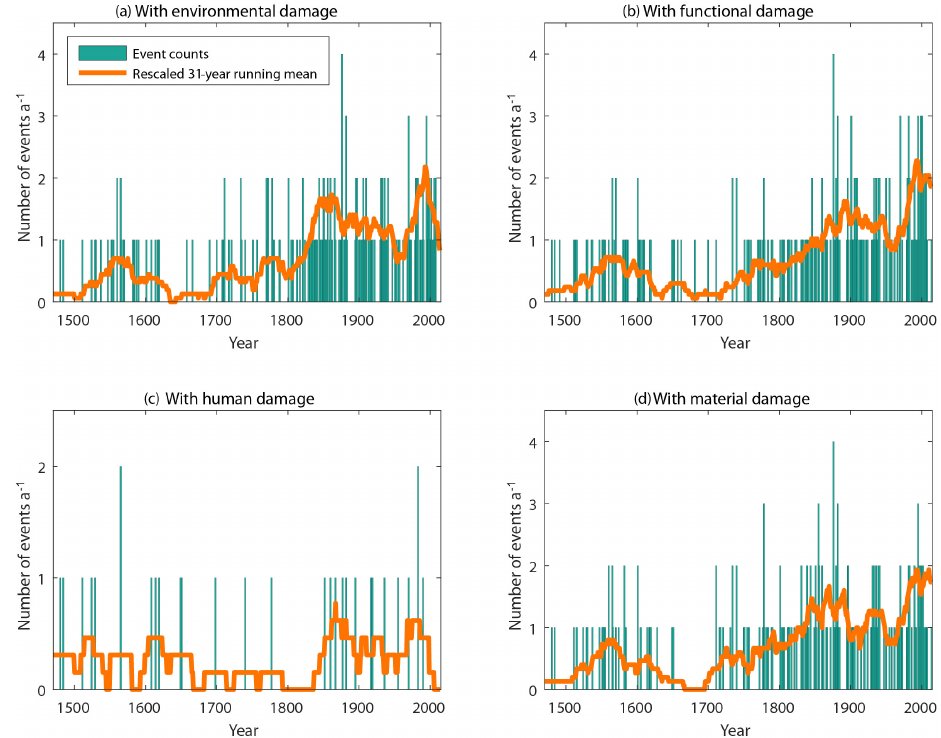
Figure 15. Chronologies of events according to their consequences (documented damage types). Human damage corresponds to at least one person killed.